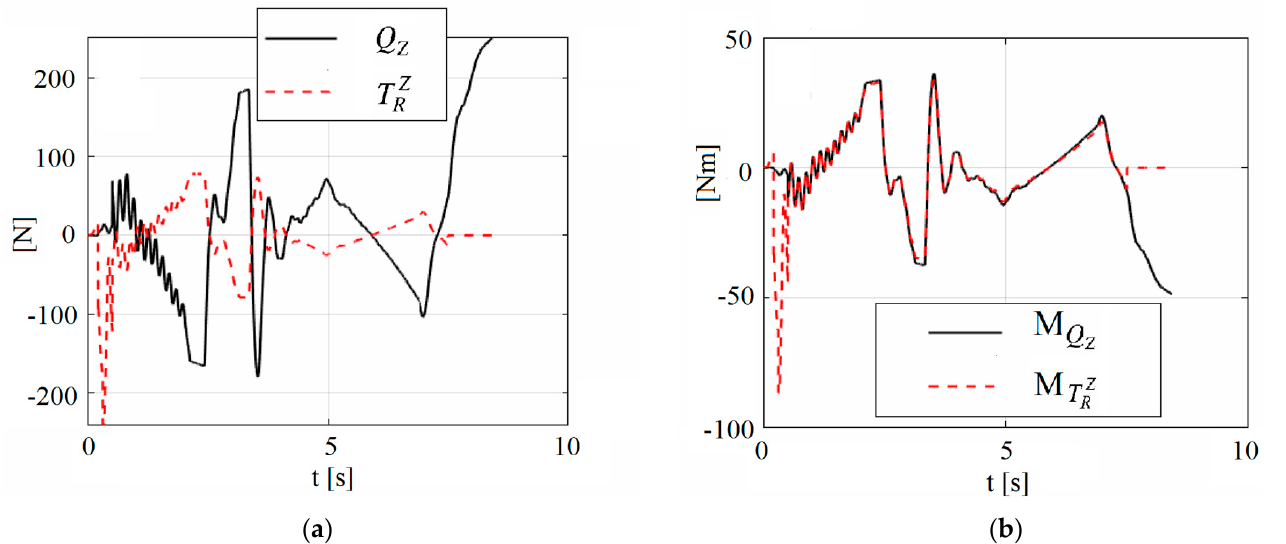
Figure 16. The performed control forces ( a ) and moments ( b ) of the anti-tank guided missile flight in the vertical plane.